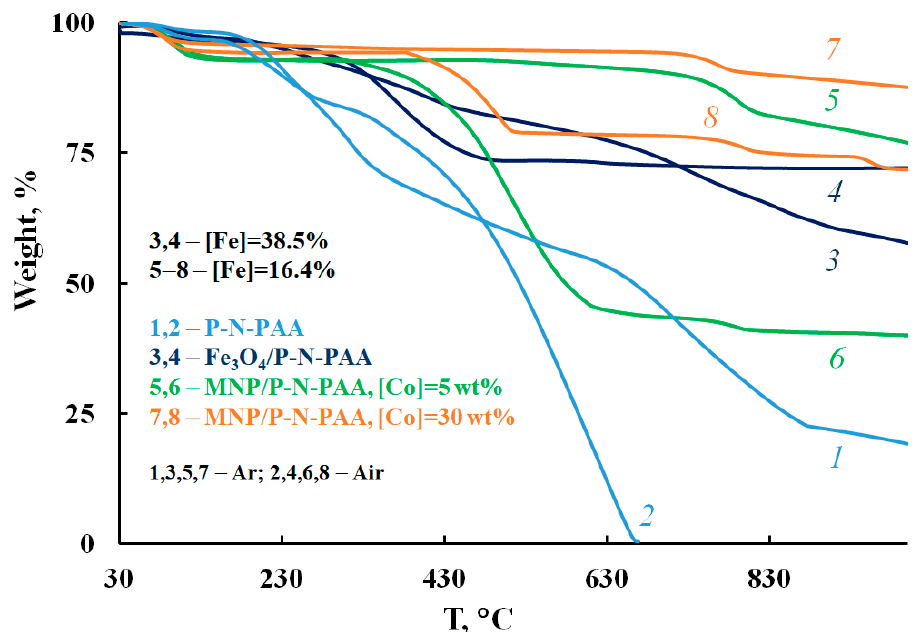
Figure 15. TGA thermograms of P ‐ N ‐ PAA (1, 2), Fe 3 O 4 /P ‐ N ‐ PAA (3, 4) and MNP/P ‐ N ‐ PAA, obtained at 800 °C, [Co] = 5 (5, 6) and 30 wt% (7, 8), in the argon flow (1, 3, 5, 7) and in air (2, 4, 6, 8). The MNP/P ‐ N ‐ PAA nanocomposites are characterized by high thermal stability that exceeds considerably the thermal stability of neat Fe 3 O 4 /P ‐ N ‐ PAA. Weight loss at low tem ‐ peratures on the TGA thermograms is associated with the removal of moisture (Figure 15). The DSC thermograms of nanomaterials show an endothermic peak at 108 °C (Figure 16). When re ‐ heated, this peak is absent, which confirms the moisture removal. As can be